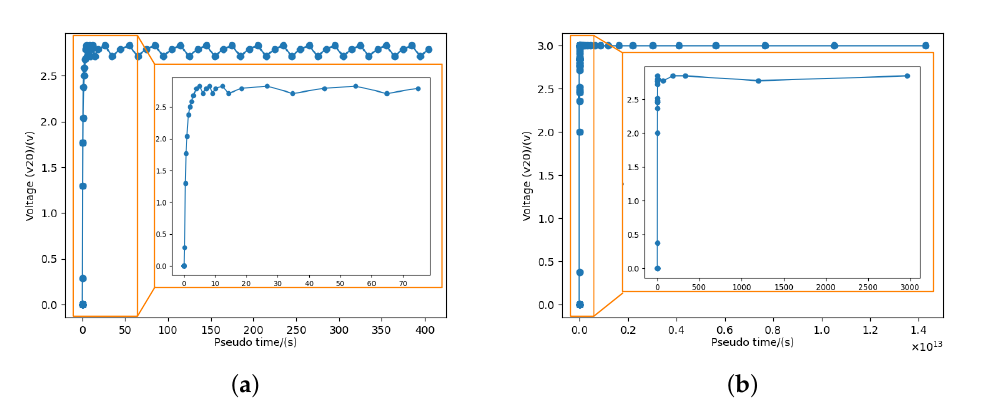
Figure 9. Comparison of the node voltage waveform on the “add20” circuit under two time-step control methods. ( a ) The voltage waveform of node 20 under conventional time-step control. ( b ) The voltage waveform of node 20 under the proposed method.